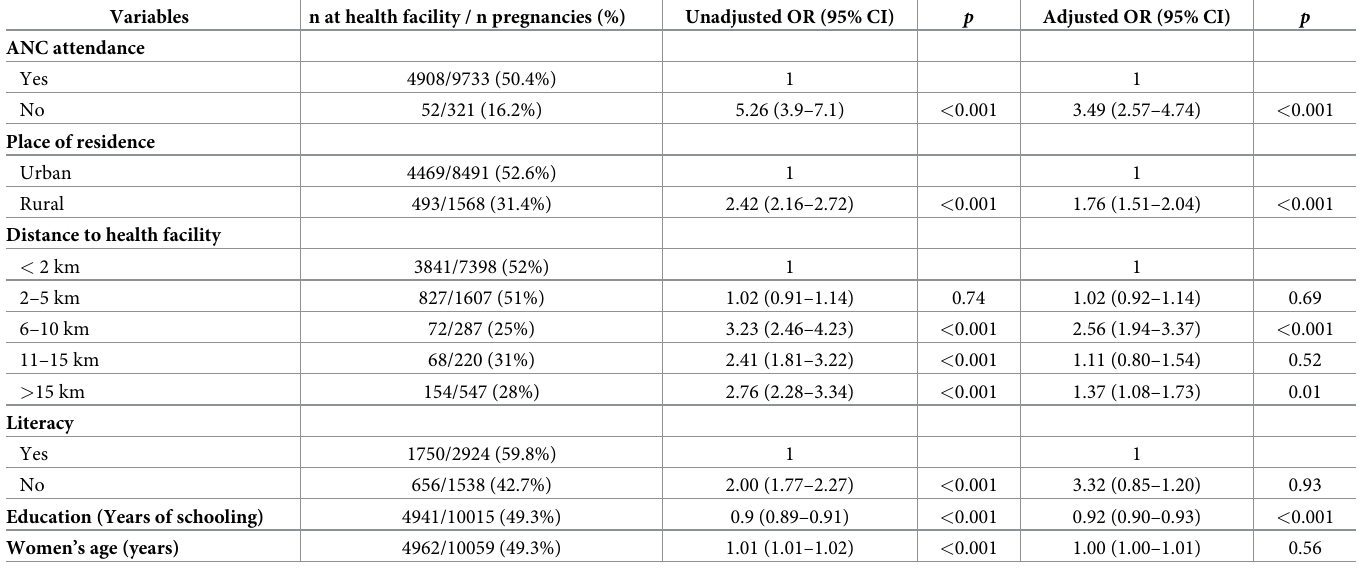
Table 5. Adjusted and Unadjusted Odds Ratios (OR) of delivery at health facilities against predictor variables. Values of OR > 1 indicate increased risk of delivery outside health facilities.